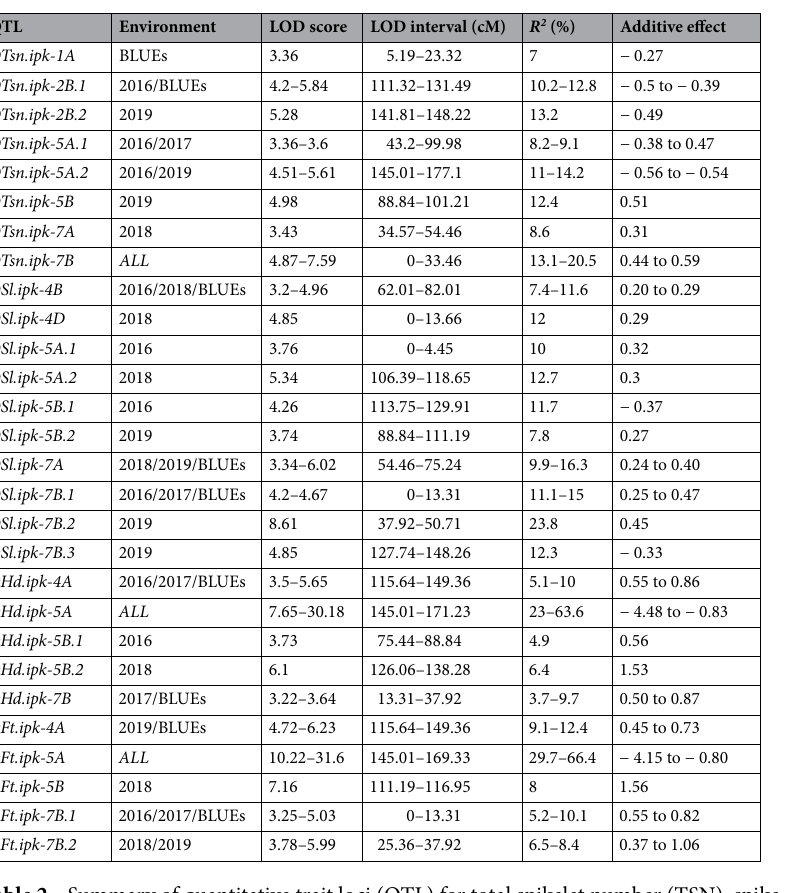
Table 2. Summary of quantitative trait loci (QTL) for total spikelet number (TSN), spike length (SL), heading date (HD), and flowering time (FT) across 4 years and their corresponding best linear unbiased estimations (BLUEs). Name of the quantitative trait loci (QTL), environment in which the QTL was identified (Environment), logarithm of odds to declare the presence of a QTL (LOD score), genetic support interval at LOD-1.5 (LOD interval), percentage of phenotypic variance explained by the QTL ( R 2 ), estimated effect of putative QTL with positive values for TRI-10703 (parent A) and negative values for TRI-5310 (parent B; additive effect). The full table with description of each individual QTL is available as Supplementary Table S1